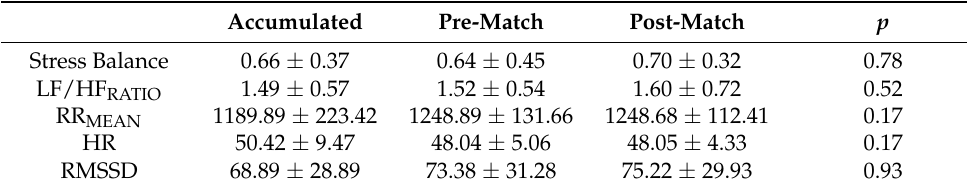
Table 1. Automatic cardiac responses during training nights, pre-match and post-match. Values are shown as mean ± standard